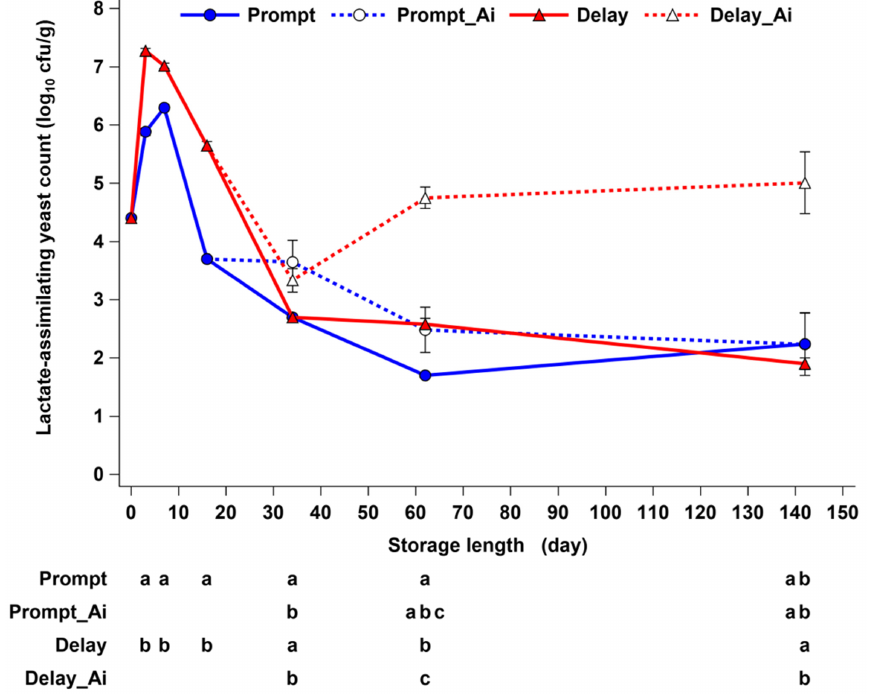
Figure 1. Changes in the concentration of lactate-assimilating yeasts during the fermentation of maize silage as affected by sealing time and repeated air ingress during 142 days of storage. Least square means are presented with standard error of means as error bars, significant differences within respective storage length are given below as plot table (a–c: means with no common letter differ at p < 0.05; pairwise comparisons by rank procedure). Prompt, promptly sealed, without air ingress during storage; Prompt_Ai, promptly sealed with air ingress after 27, 55, 135 days of storage; Delay, sealed with 24 h delay, without air ingress during storage; Delay_ Ai, sealed with 24 h delay and air ingress after 27, 55, 135 days of